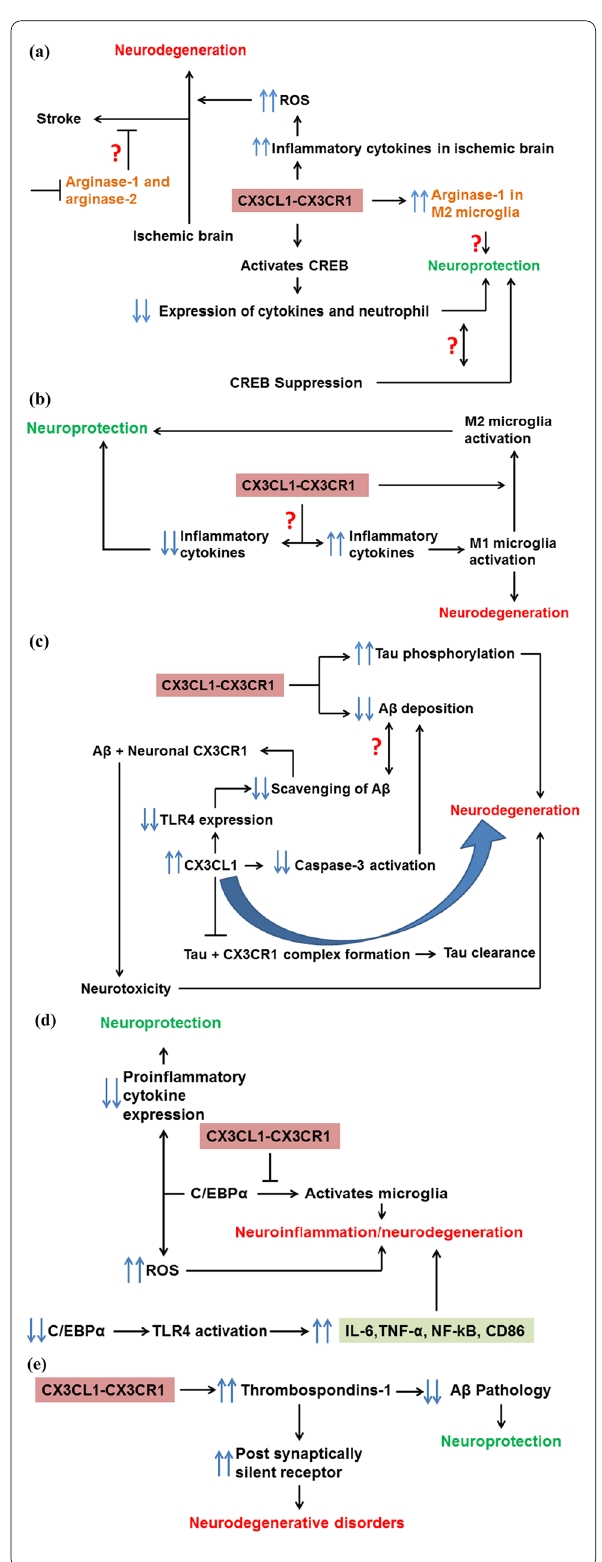
effect on INF-γ production, membrane bound CX3CL1 is a strong inducer of INF-γ by natural killer (NK) cells [55] and brain has clusters of NK cells [60]. It seems, CX3CL1 and INF-γ can induce expression of each other